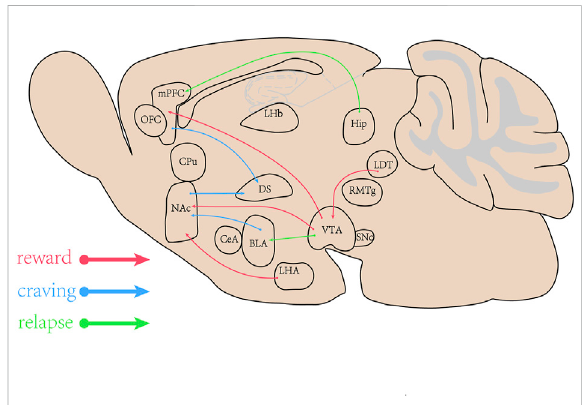
FIGURE 1 The brain areas involved in methamphetamine (METH) addiction. The ventral tegmental area (VTA), the nucleus accumbens (NAc), the dorsal striatum (DS), the medial prefrontal cortex (mPFC), the Hippocampus (Hip), amygdala (BLA) and their projects or inputs play the important roles in rewarding effects, craving and relapse induced by abuse